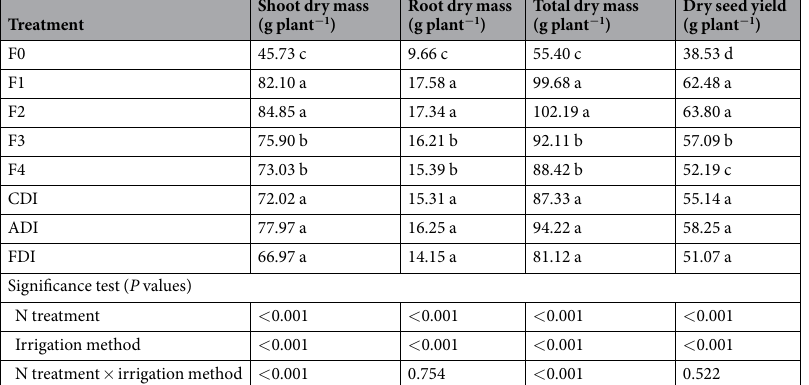
(Table 2). Compared to CDI, ADI and FDI decreased mean water consumption of maize by 19.9% and 19.8%, respectively. Hence, ADI and FDI enhanced WUEt by 34.4% and 15.7%, and WUEs by 32.3% and 15.6%, respec-